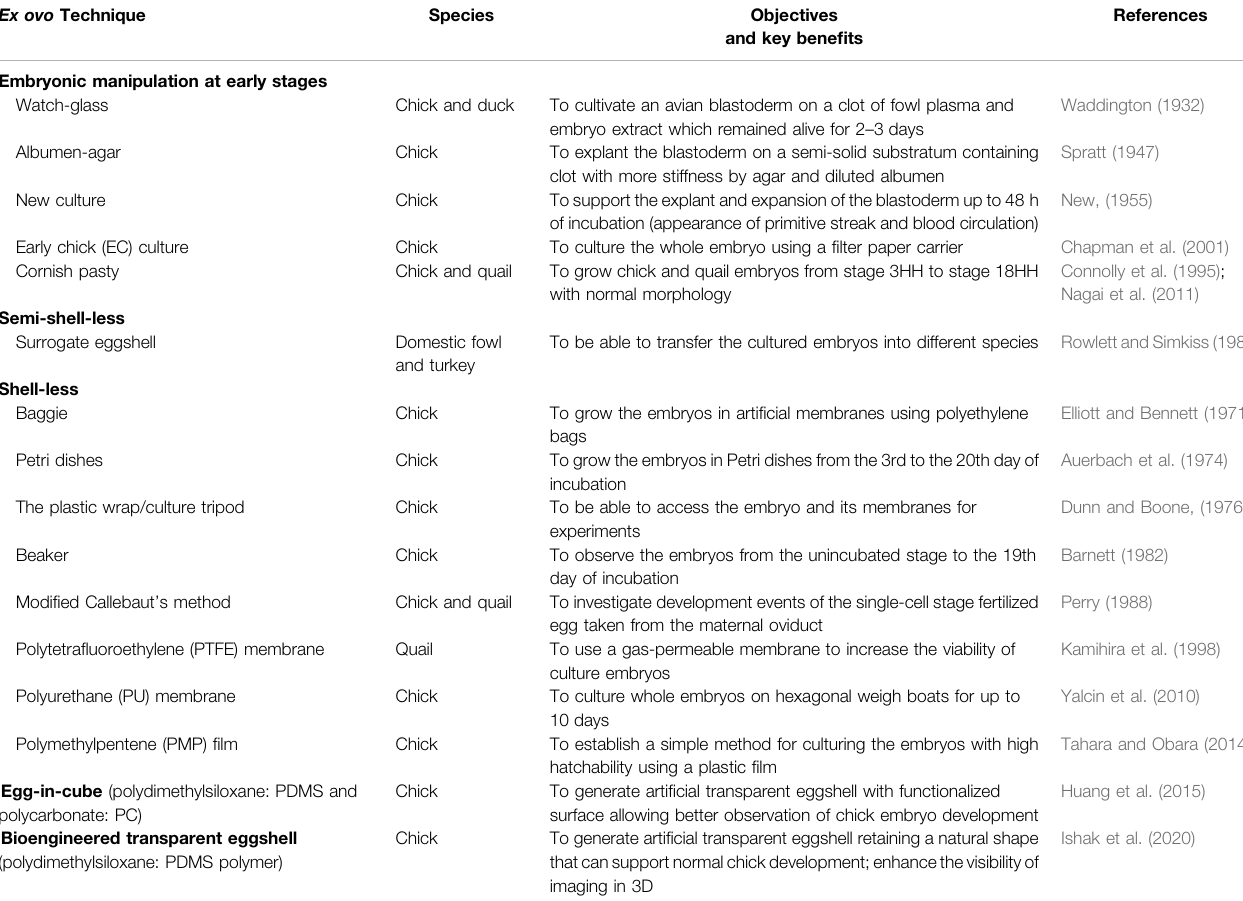
TABLE 1 | Timeline of ex ovo techniques developed to understand the embryonic development in avian